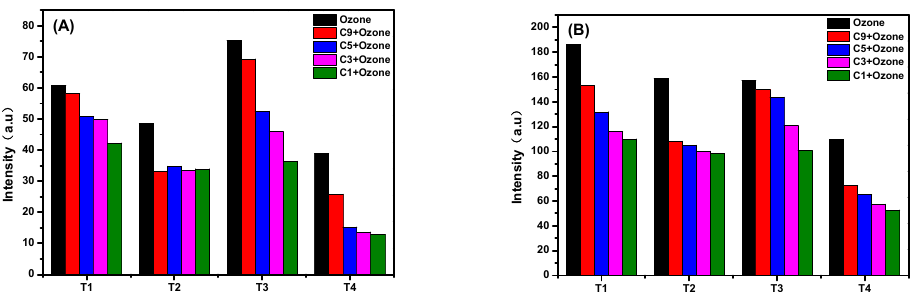
Figure 3. Intensities and positions of the EEM peak maxima after ozonation and catalytic ozonation. (sample A: ( A ), sample B: ( B )), commercial γ -Al 2 O 3 was mechanically broken into different particle sizes, and the particles were passed through screen mesh with different pore sizes so that they were divided into sizes of approximately 0.9 mm, 0.5 mm, 0.3 mm and 0.1 mm, which were named C9, C5, C3, and C1, respectively.